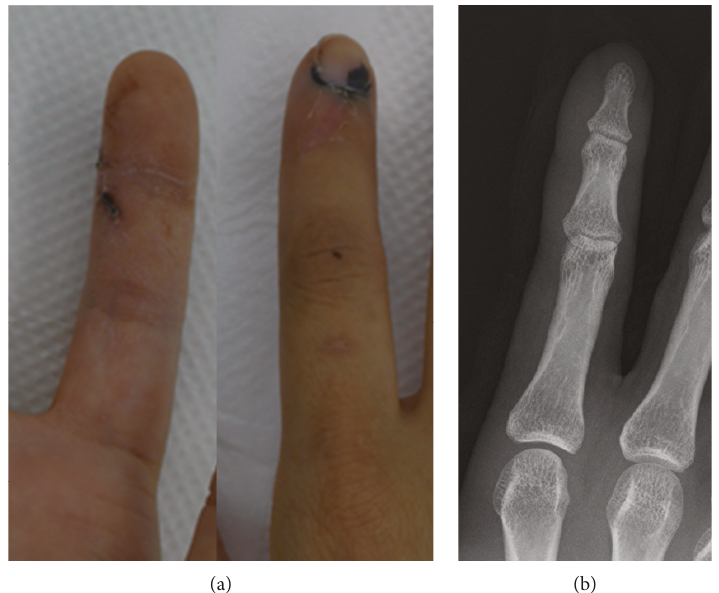
Figure 1: Macro and radiological fi ndings. (a) Macro fi nding at 2 weeks after injury. A scar around the ulnar side of the distal interphalangeal (DIP) joint and submaxillary hematoma in index fi nger was observed. (b) X-ray fi nding. No fracture was observed.